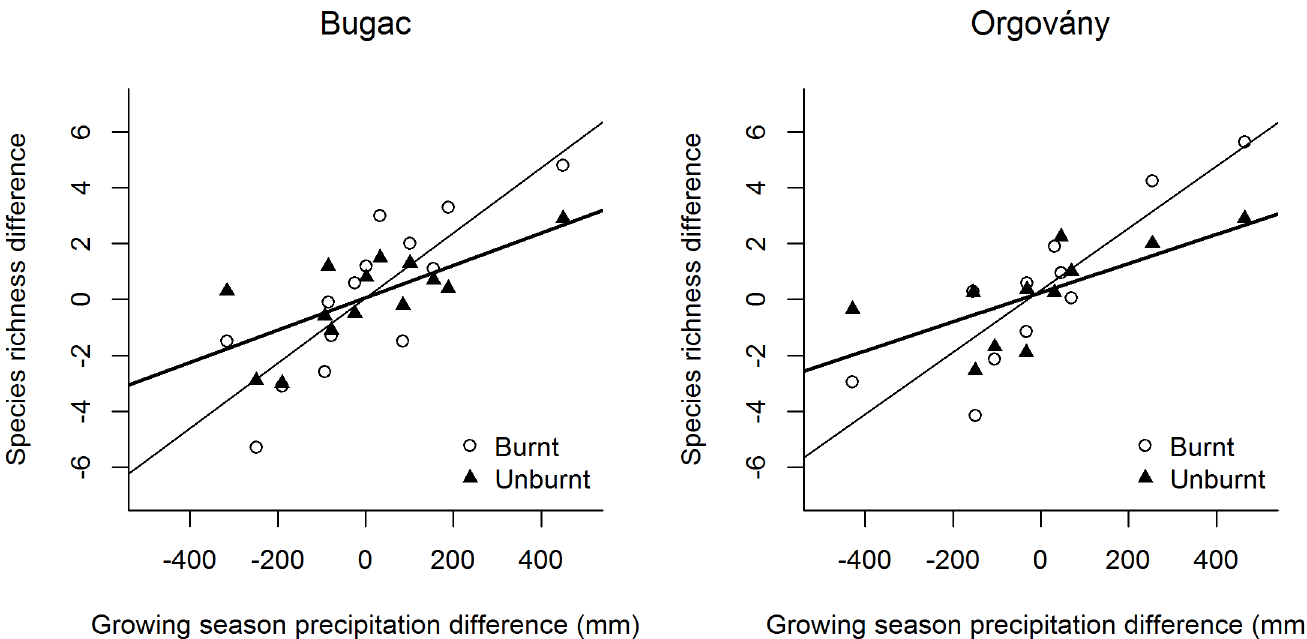
Fig 2. The relationship between year-to-year differences in growing season precipitation and species richness. Trend lines denotesignificant (p < 0.05)regressions. Bold trend lines stand for unburnt areas, and regularones for burnt areas.